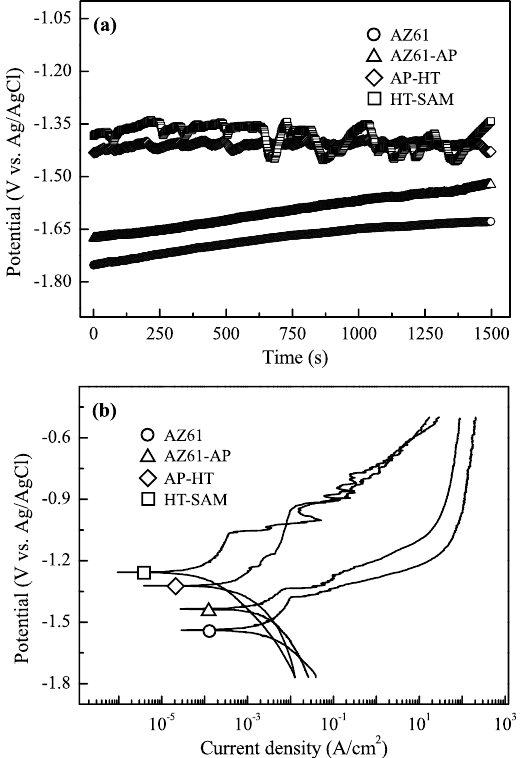
Figure 6. ( a ) OCP curves and ( b ) potentiodynamic polarization curves of the AZ61 Mg alloy, AZ61-AP, AP-HT and HT-SAM specimens tested in R-SBF solution at 37